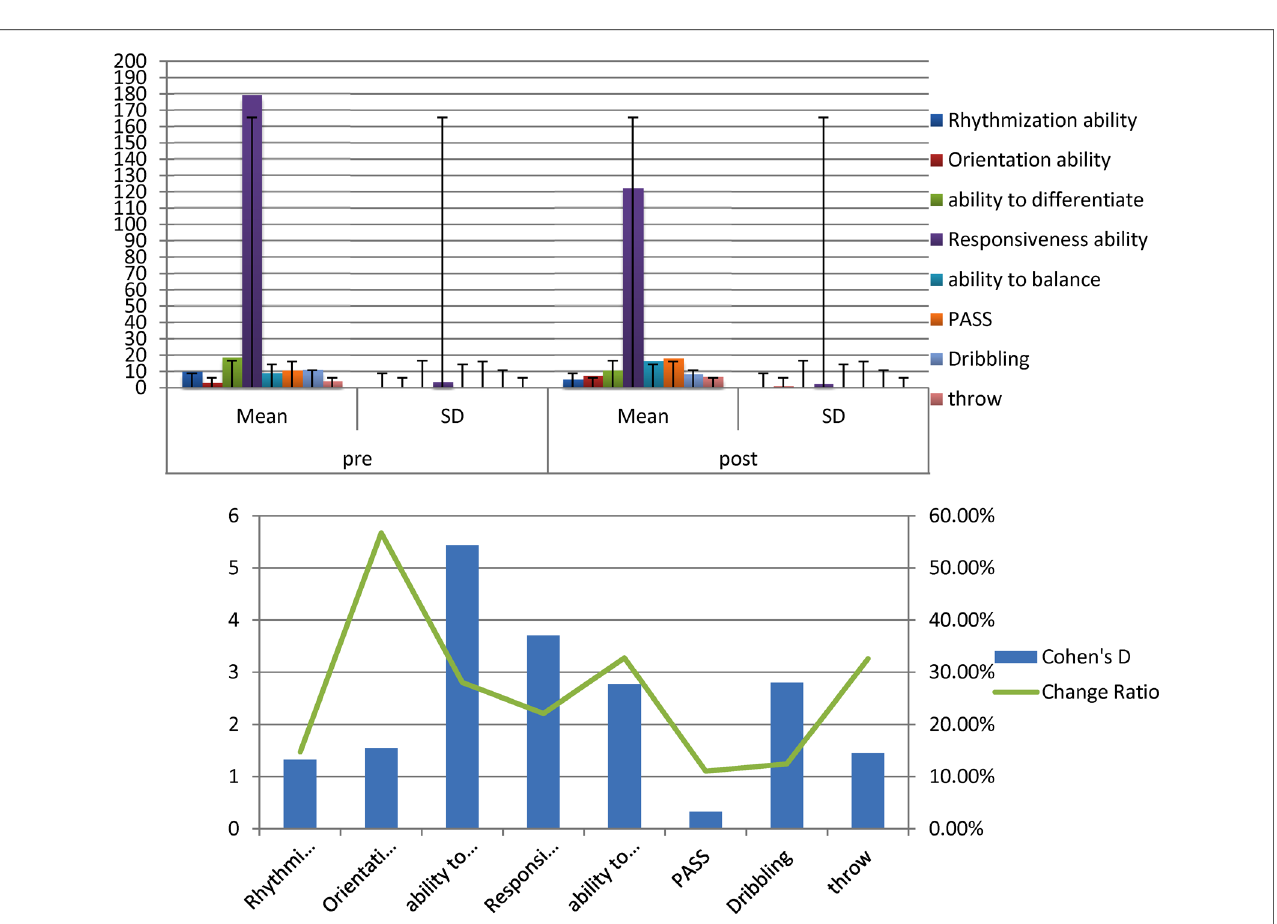
FIGURE 2 Indication of differences between the averages of pre and post measurements of the experimental group in the variables under